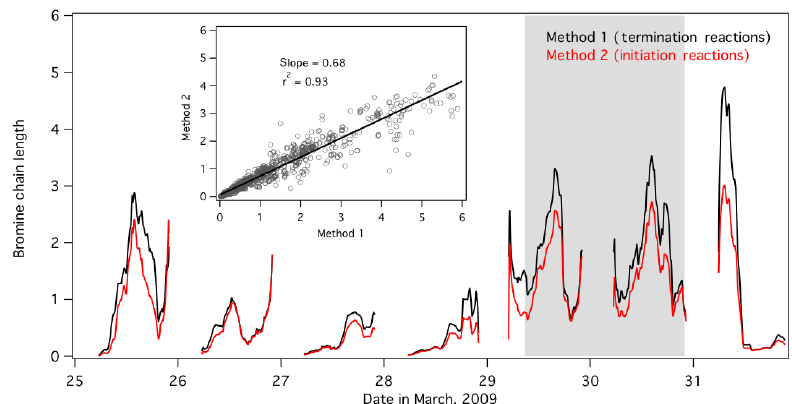
Figure 3. Time series of model-calculated bromine chain length for the daytime hours (07:00 to 21:00AKST). Method 1 is plotted as the black trace and Method 2 is plotted as the red trace. Model output is smoothed by hourly averaging. The grey-shaded box represents a period of missing Br 2 observations. The inset graph shows a linear regression of Method 1 and Method 2 calculations. Time is expressed in Alaska standard